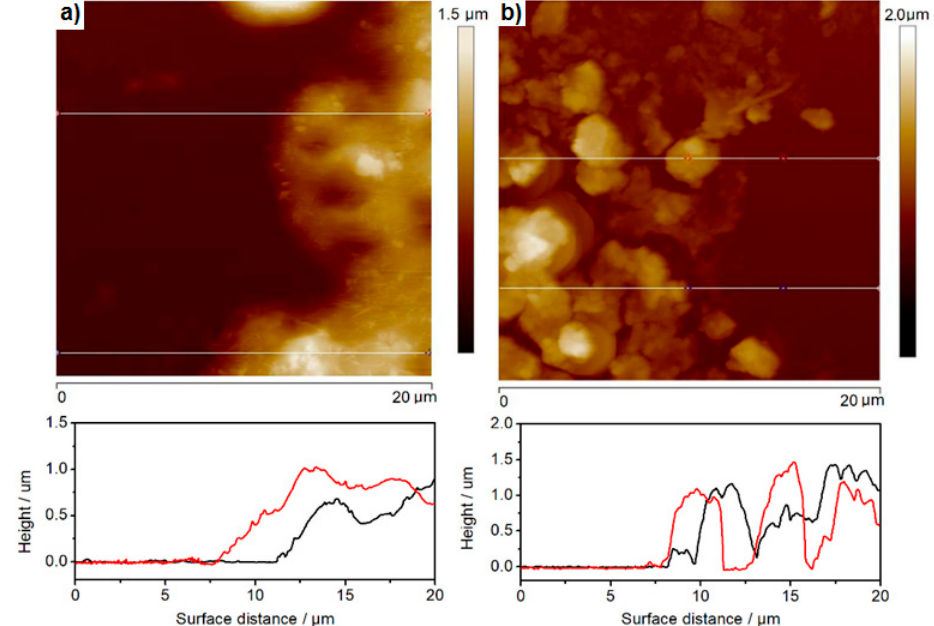
Figure 6. Atomic Force Microscopy (AFM) images and film edge analysis of thickness of ( a ) hydrophobic and ( b ) hydrophilic CdS nanoparticles L-B transferred or drop-cast on ITO, respectively. Red curve—scan forward for the scratching needle, black curve—reverse for the scratching needle.